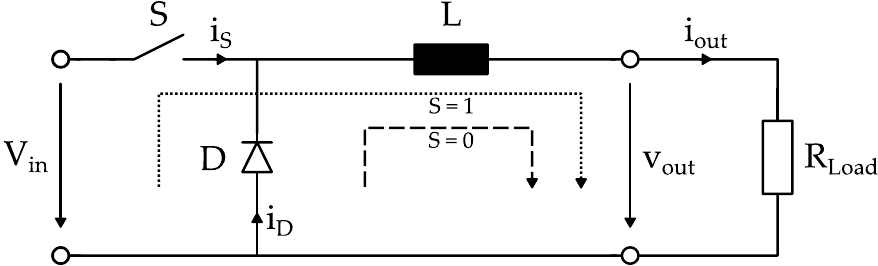
Figure 1. Equivalent circuit diagram of a buck converter. The two dedicated current paths are indicated by differently dashed lines [34].